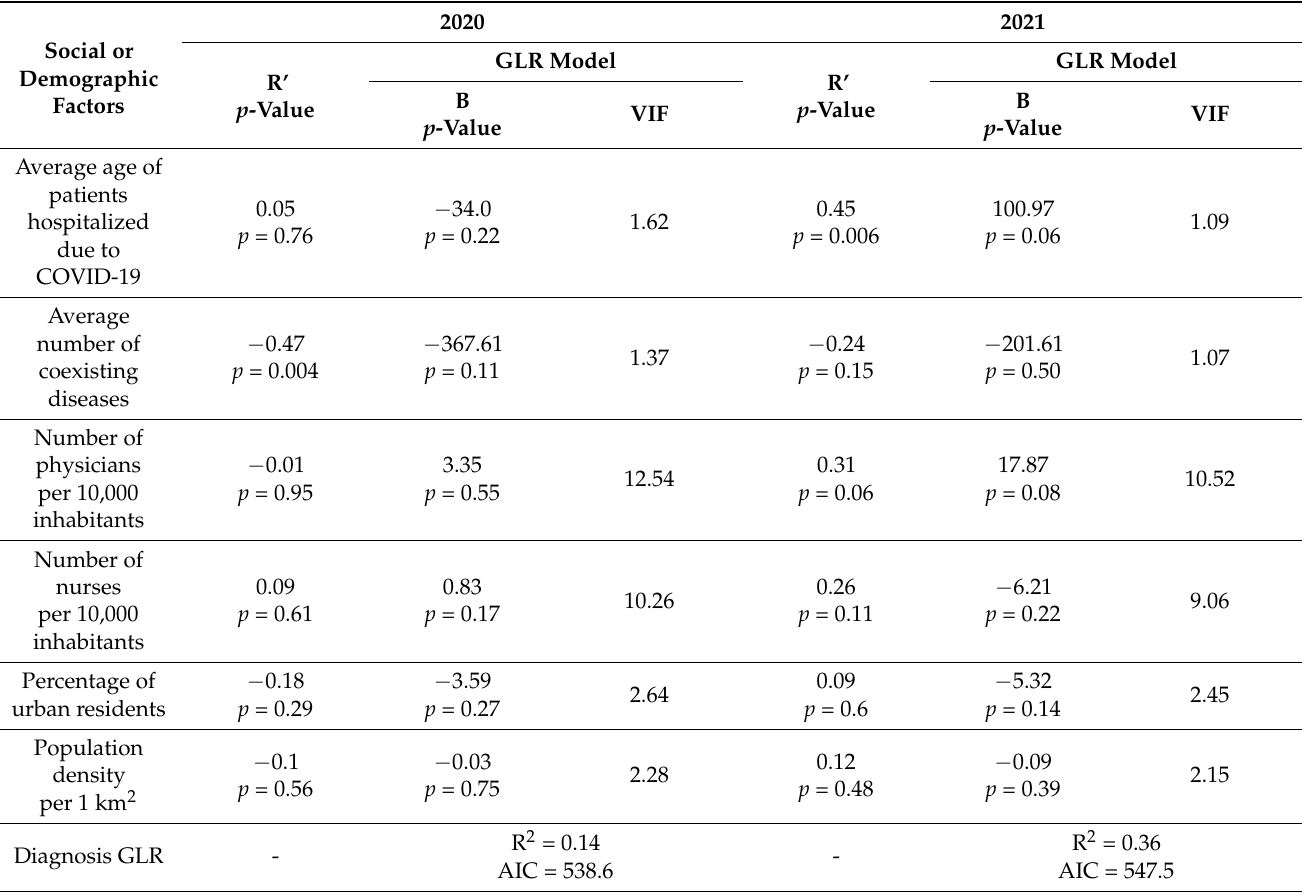
Table 3. Correlation between the number of patients hospitalized due to COVID-19 in hospitals of the Silesian Voivodeship in 2020 and 2021, and social or demographic factors by